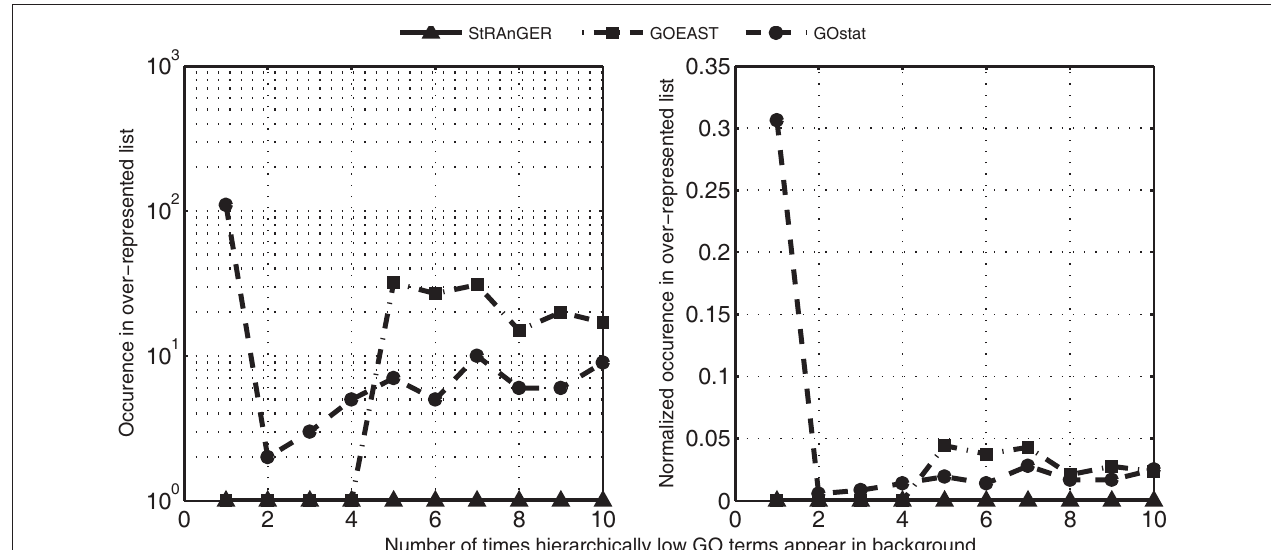
frequency GO terms in the significantly over-represented GO terms (how many times these terms infiltrate the significant list), resulting from the usage of the three packages, while in the right panel, the count of low frequency GO terms is normalized to the total number of over-represented GO terms returned by each package. In both cases, StRAnGER performs, as its curve shows, better or at the same level (in the case of GOEAST for very low frequency terms) with the others, implying that its prioritization algorithm manages to filter out noise caused by very specific functions, being low at the GO hierarchy, without the application of any multiple-testing correction methodology, a strategy reported as controversial (see main text).